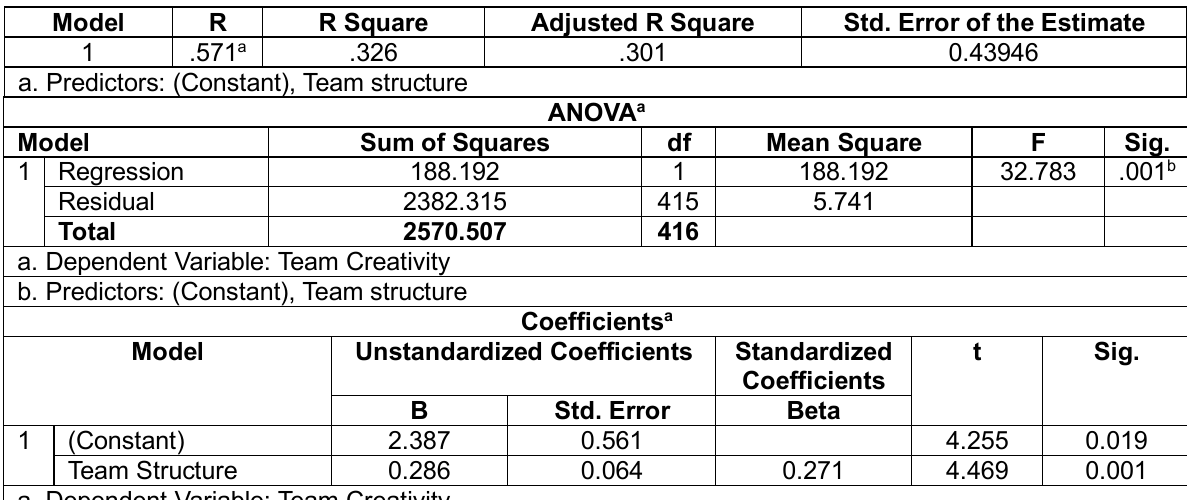
Table 8 : Regression Analysis for Team Structure and Team